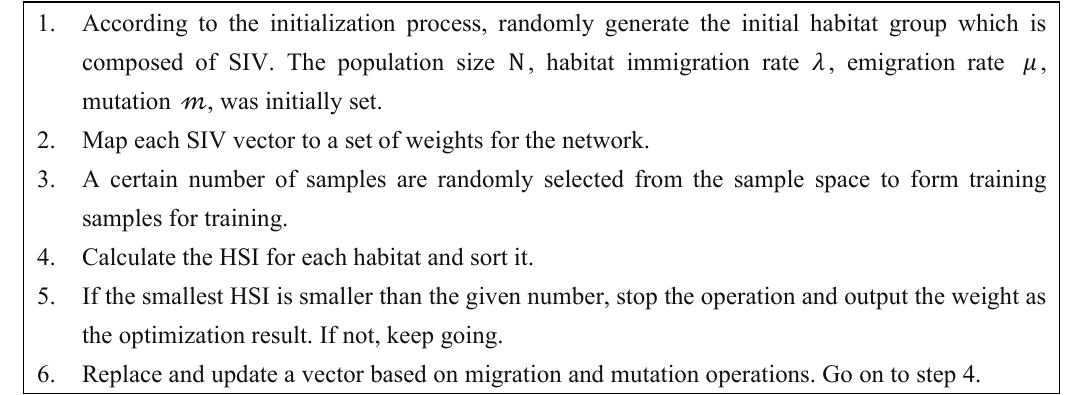
Figure 6. Block diagram of the whole system . Figure 5. Pipeline of BBO algorithm. Algorithm 3. Pseudocode of